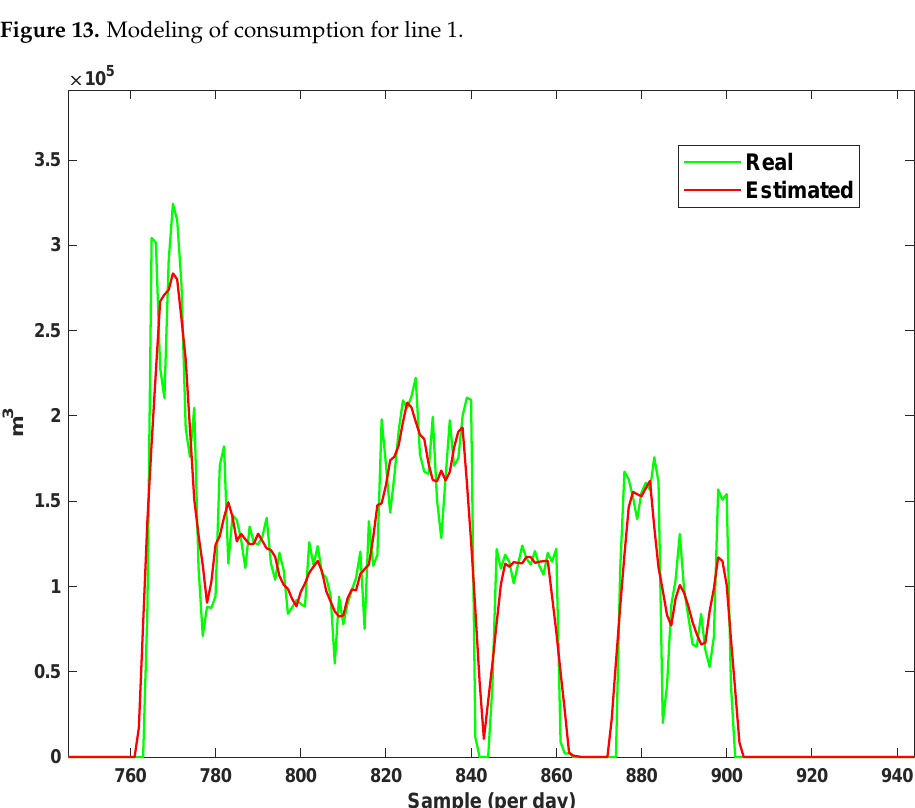
Figure 14. Modeling of consumption for line 1: Zoomed